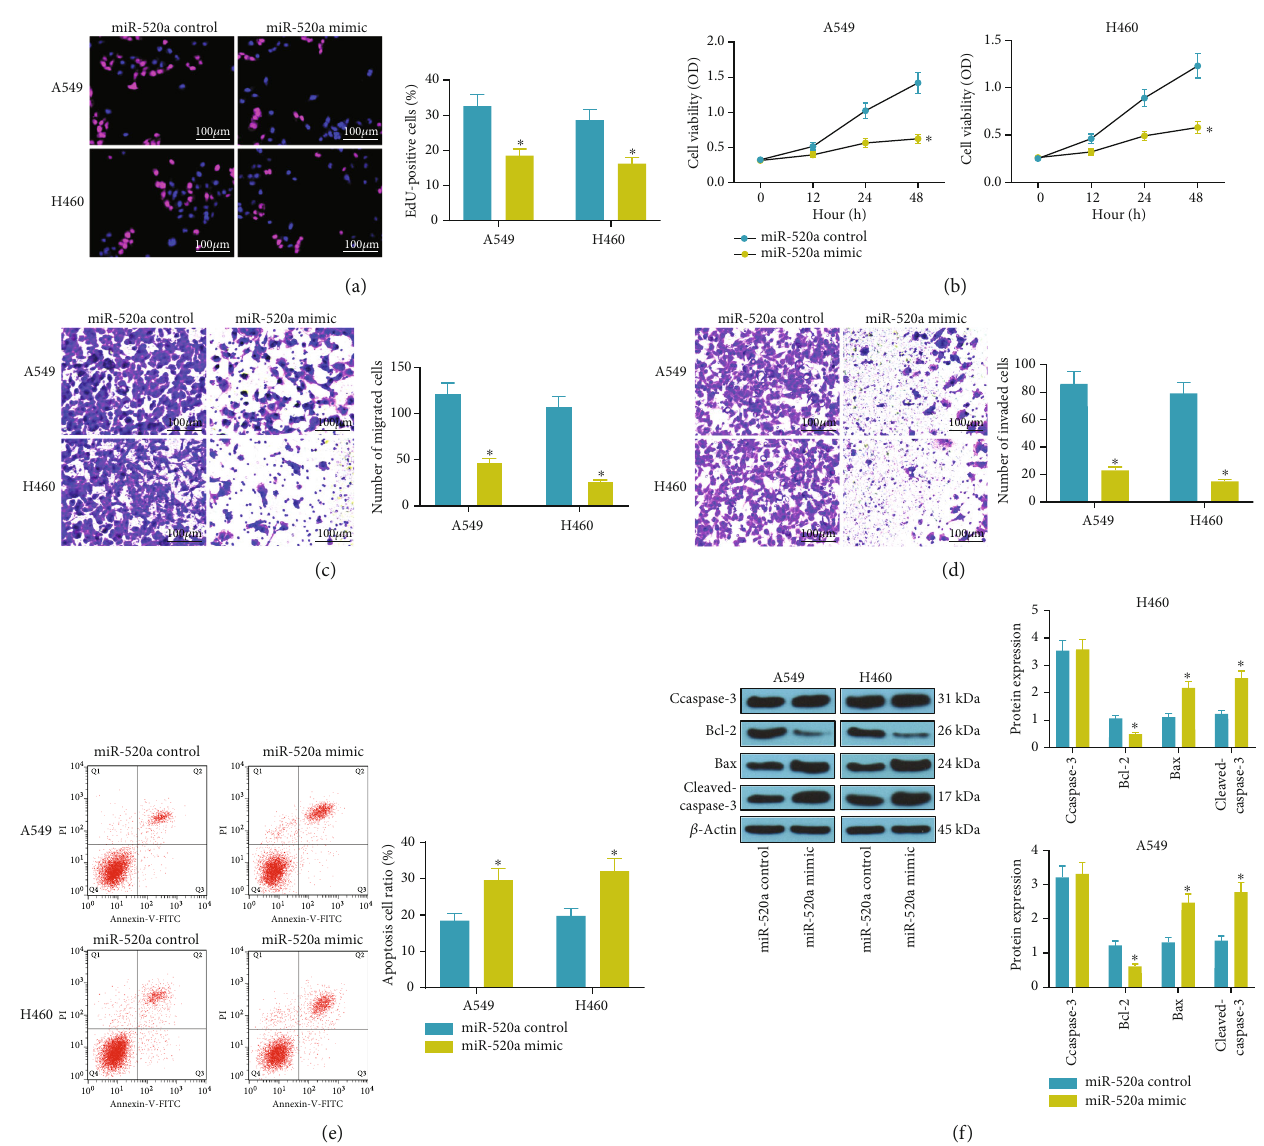
Figure 2: Arti fi cial upregulation of miR-520a inhibits NSCLC progression. (a) Viability of A549 and H460 cells determined by the EdU labeling assay ( ∗ p < 0 : 05 , two-way ANOVA). (b) Proliferation of A549 and H460 cells after miR-520a transfection determined by the MTT assay ( ∗ p < 0 : 05 , two-way ANOVA). (c, d) Changes in number of migrating (c) and invading cells (d) detected using the transwell assays ( ∗ p < 0 : 05 , two-way ANOVA). (e) The apoptosis rate of A549 and H460 cells determined by fl ow cytometry ( ∗ p < 0 : 05 , two-way ANOVA). (f) Protein levels of apoptosis-related factors Bcl-2, Bax, caspase-3, and cleaved caspase-3 determined by western blot analysis ( ∗ p < 0 : 05 , two-way